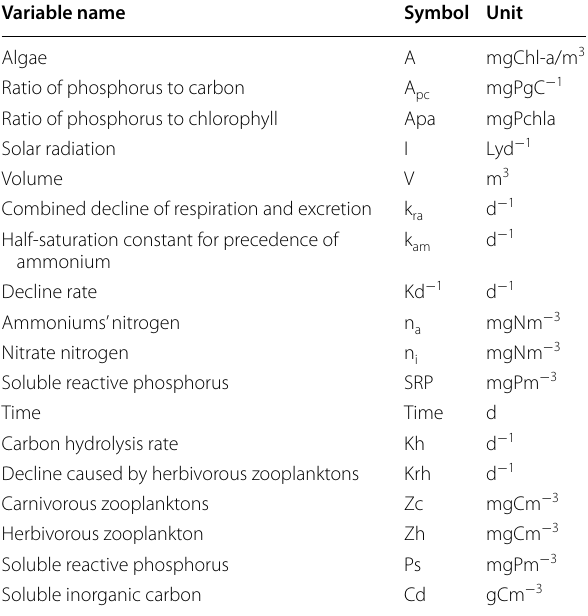
Table 1 Parameters, symbols and units used in the model